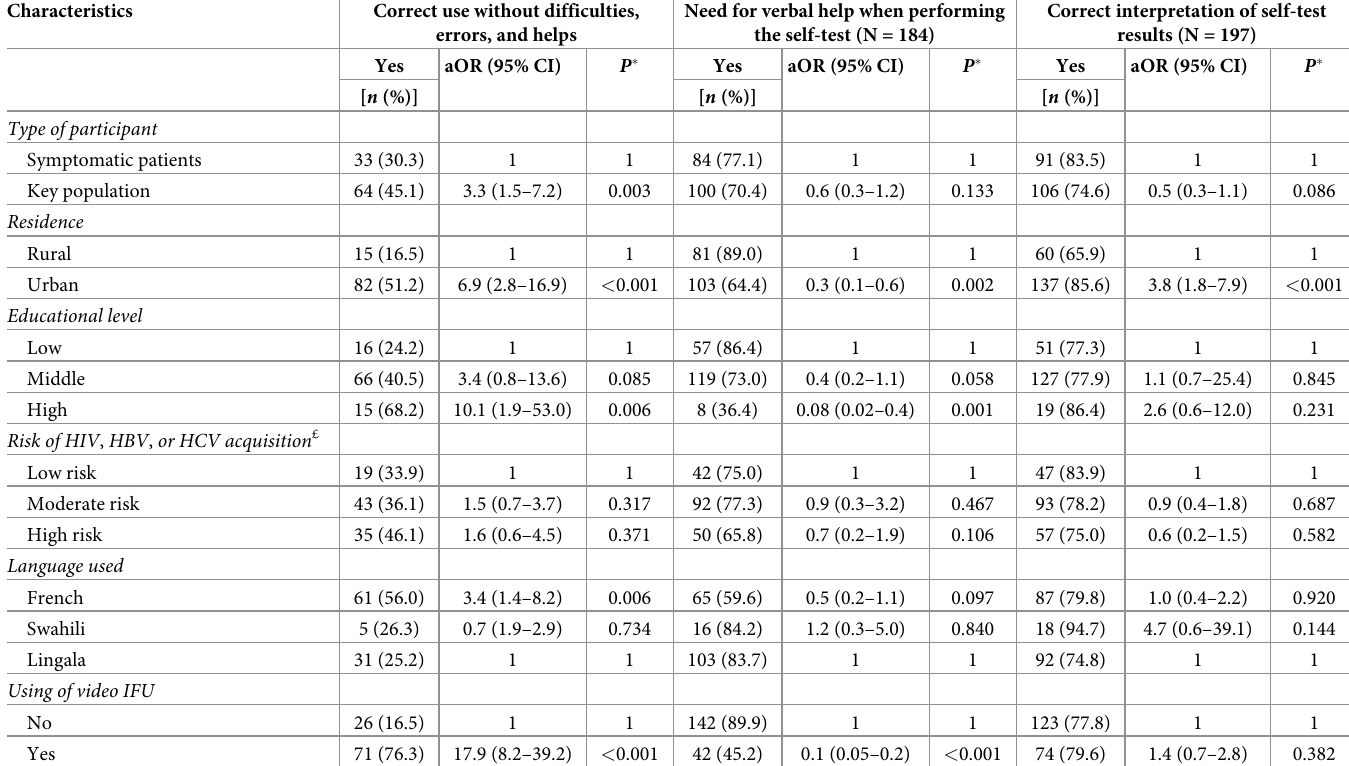
Table 3. Multivariate regression analysis of factors associated with the correct use without difficulties, errors, and helps (substudy 1), the need for verbal help when performing the self-test (substudy 1), and the correct interpretation of the Triplex HIV/HCV/HBsAg self-test results (substudy 2) among the 251 study